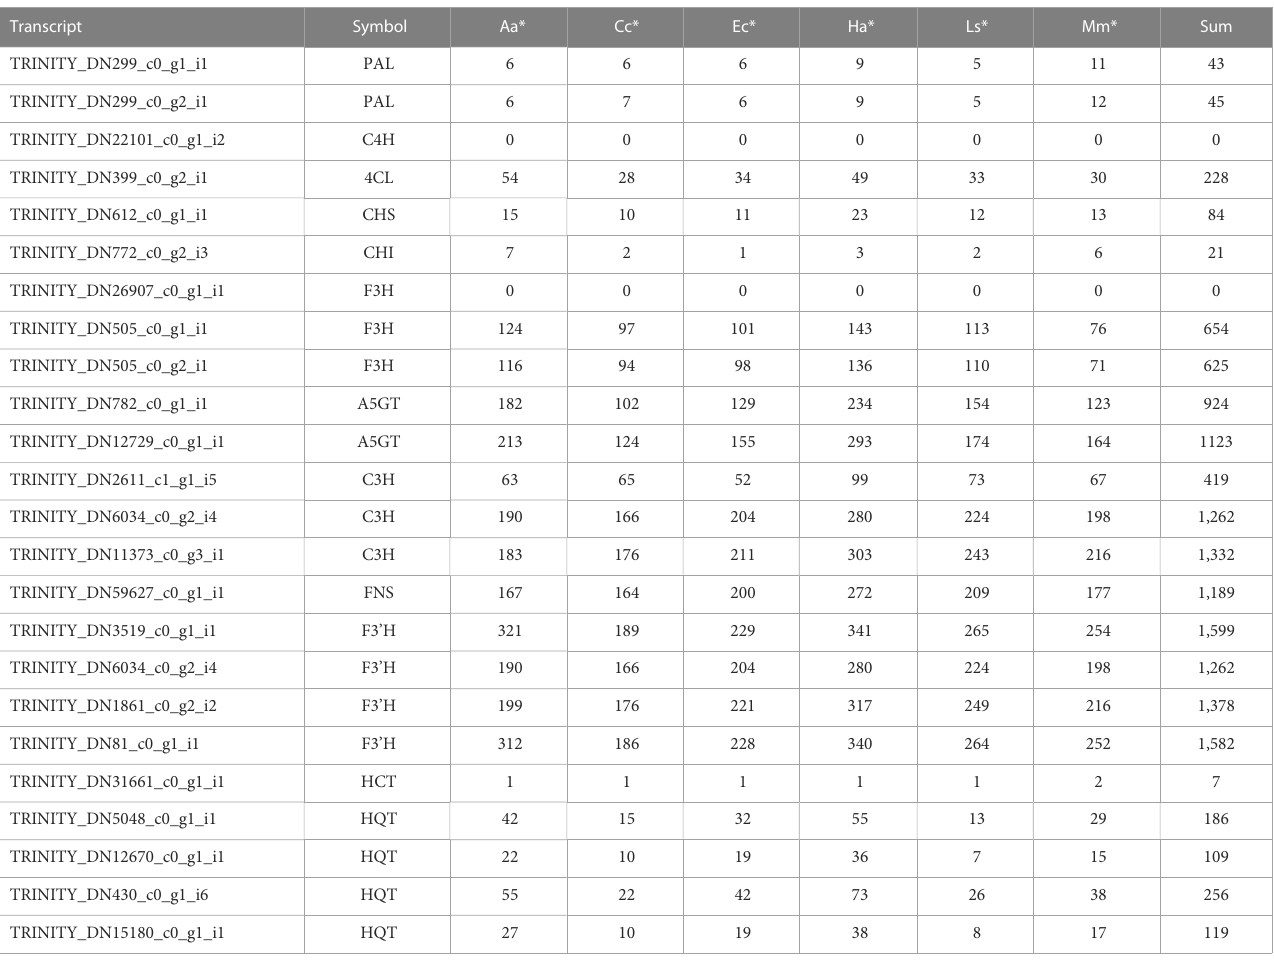
TABLE 5 The number of BLASTP hits (E-value < 1e-30) of the translated transcripts shown in Figure 4 . Transcript